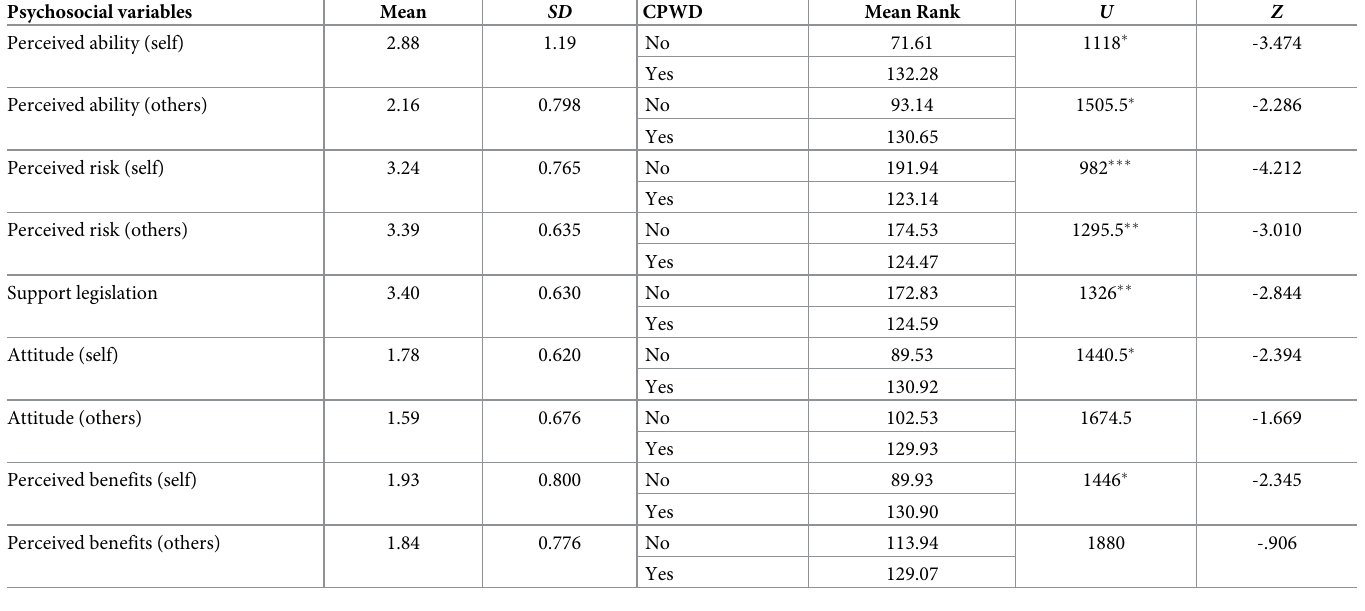
Table 3. The Mann–Whitney U test analysis of perceived ability, risks, support for legislation, attitudes and benefits between the two groups of users and non- users. Psychosocial